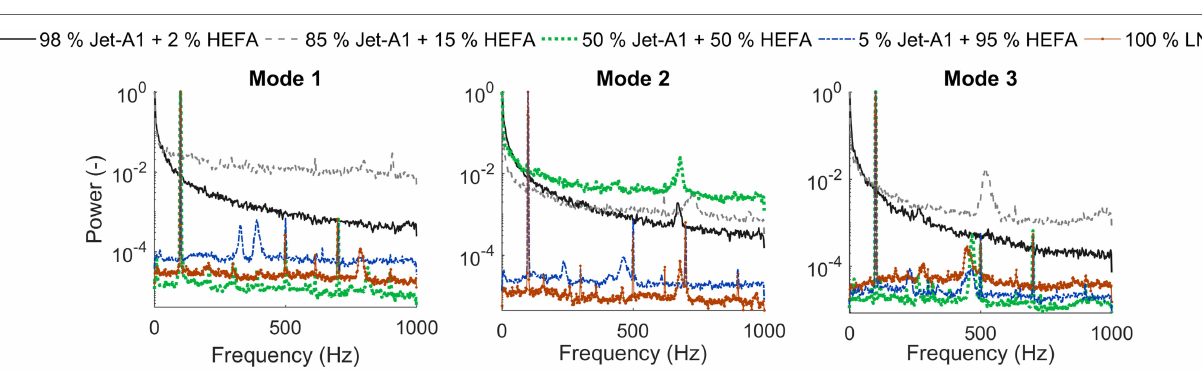
Frontiers in Built Environment |